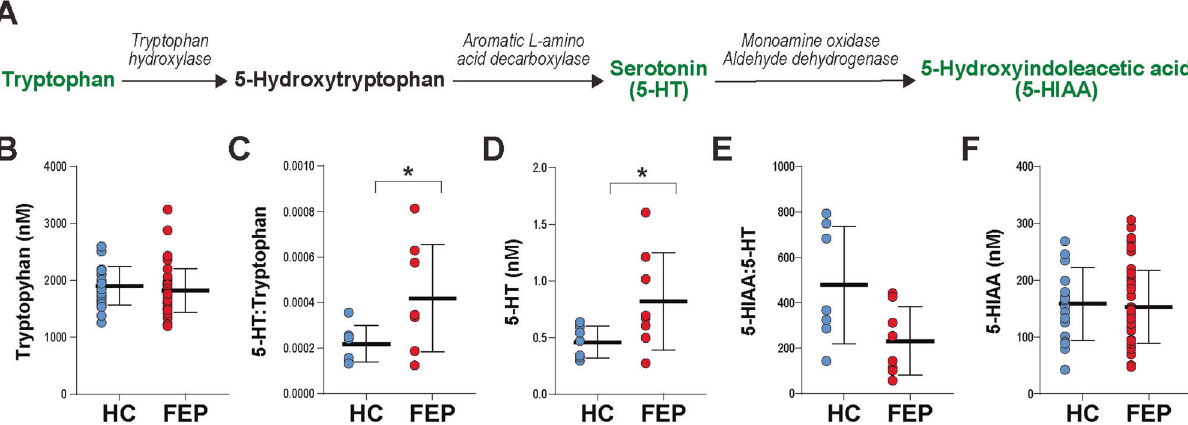
Fig. 2 Serotonin and related metabolite levels in the baseline CSF samples of fi rst-episode psychosis (FEP; n = 47) patients and healthy controls (HC; n = 21) identi fi ed by HPLC and LC-MS/MS. Tryptophan was detected in 68 samples (47 FEP and 21 HC), serotonin was detected in 15 samples (8 FEP and 7 HC), while 5-hydroxyindoleacetic acid (5-HIAA) was detected in 67 samples (47 FEP and 20 HC). A Serotonin synthesis pathway and enzymes involved are illustrated. Metabolites measured in the validation experiment are highlighted in green. Mean levels ± SD of ( B ) tryptophan, ( C ) serotonin-to-tryptophan ratio, ( D ) serotonin, ( E ) 5-hydroxyindoleacetic acid-to-serotonin ratio, and ( F ) 5-hydroxyindoleacetic acid are shown. Asterisks (*) represent differences between the FEP patients and HC after adjusting for age, antidepressant use, and nicotine use at p < 0.05. Standardized residuals are shown in Supplementary Fig.